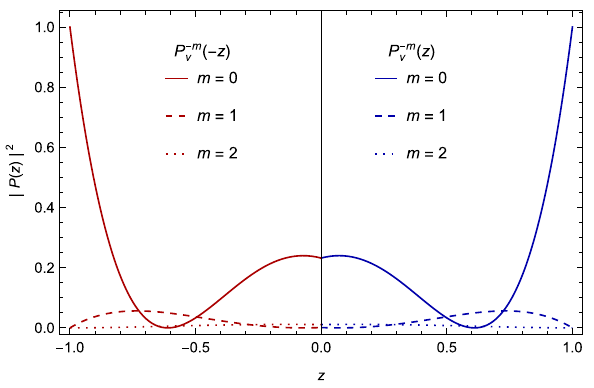
Fig. 4 (dS) Case 1: a < 0. The first three squared QBS angular wave eigenfunctions as a function of the new polar coordinate z ; a = − 0 . 20, (cid:2) = 0 . 1, n = 0, M = 1 /